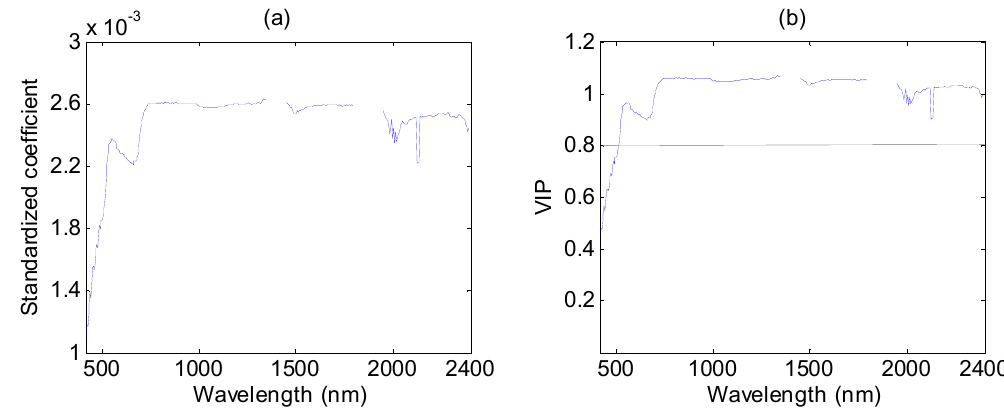
Figure 5. The standardized coefficients for the partial least squares regression (PLSR) model ( a ). Panel ( b ) shows the variable importance of projection (VIP) values for the PLSR model. The VIP values less than 0.8 indicates little influence on the regression model.